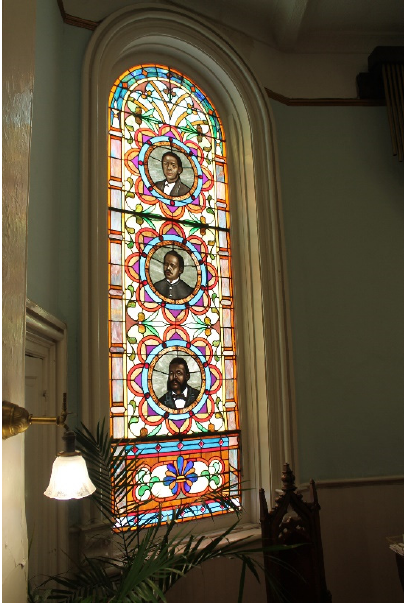
Figure 13. Stained glass imagery of former pastors of the First African Baptist Church, Savannah, Georgia. Image by the author. October 2014.